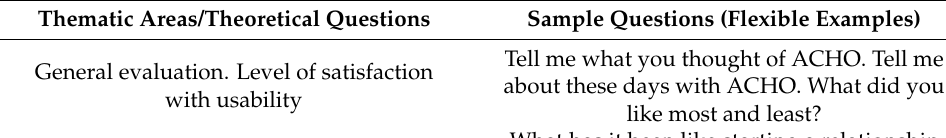
Table 1. Questions used as a reference to guide the ad hoc semi-structured